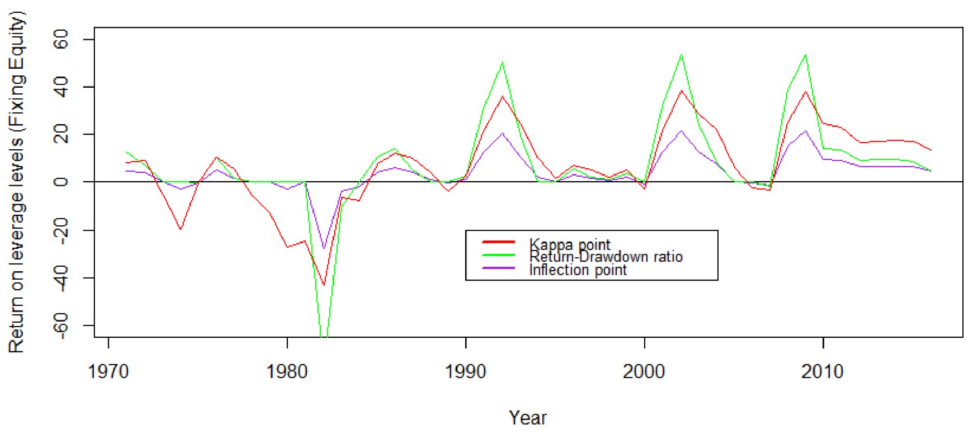
Figure 11. Return on changing leverage levels κ -red, ζ -blue, and ν -green vs. year in x-axis.